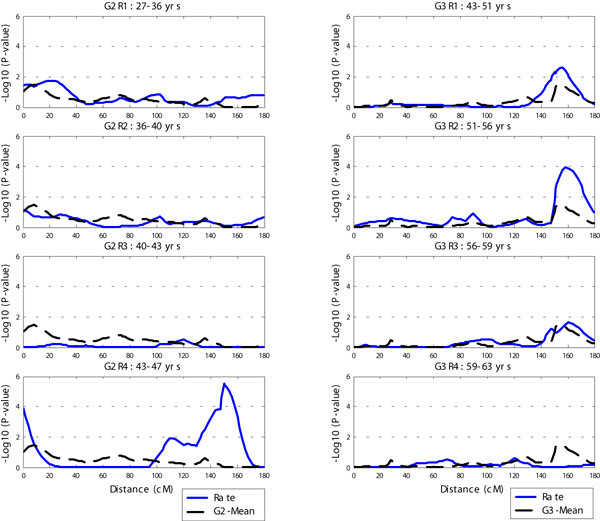
Comparison of linkage results for young (G2) versus old (G3) subjects Genetic distance (cM) is plotted for markers on chromosome 8 on the x-axis. R1-R4 in G2 was compared with R1-R4 in G3 (left and right; solid lines), and each contrasted with the mean glucose (dotted lines). The negative log10 (P-value) for linkage is plotted on the y-axis. P-values of 10-2 and 10-4 are shown as horizontal dotted lines perpendicular to the y-axis.